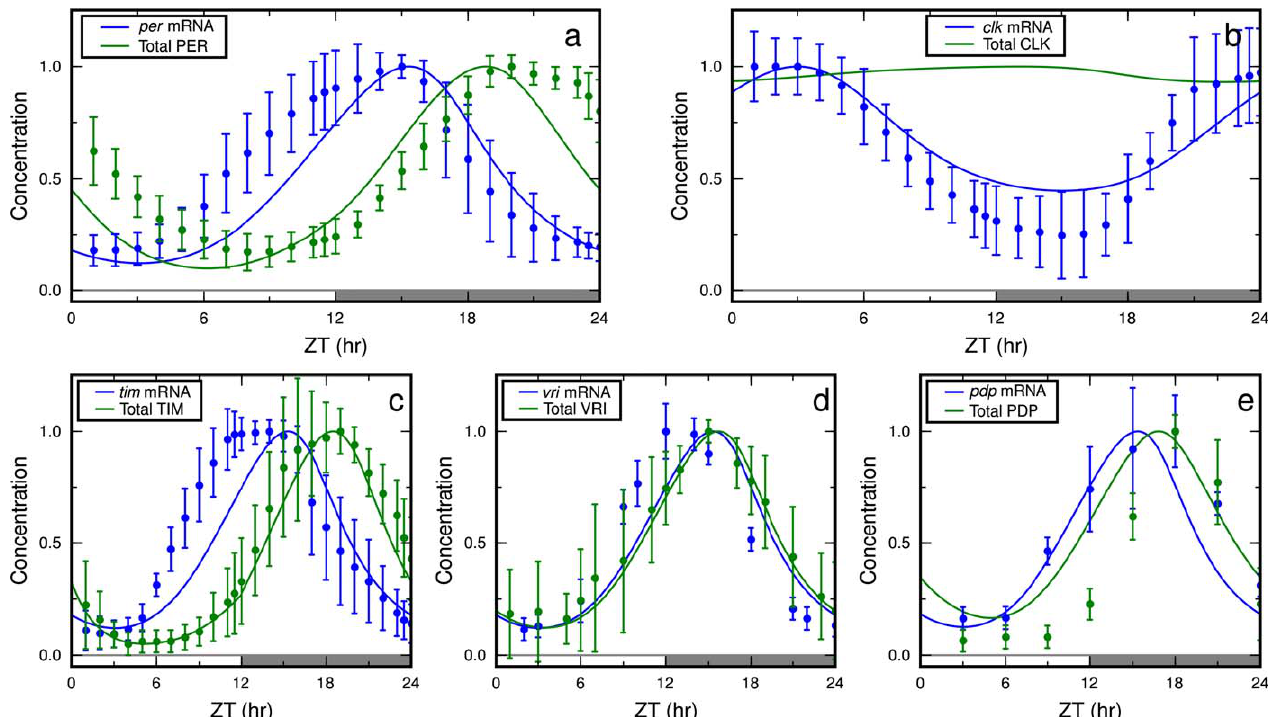
Figure 6. Comparison of the Results with the Experimental Data The expression profiles of per (A), clk (B), tim (C), vri (D), and pdp (E) mRNA and total protein from the detailed model results (lines) were compared with experimental observations (points with error bars generated from the average and standard deviation of published experimental data, see Table S4). Model results and experimental data were normalized to 1.0. Bars along the horizontal axis indicate light entrainment regime: light-on (empty) or light-off (filled).